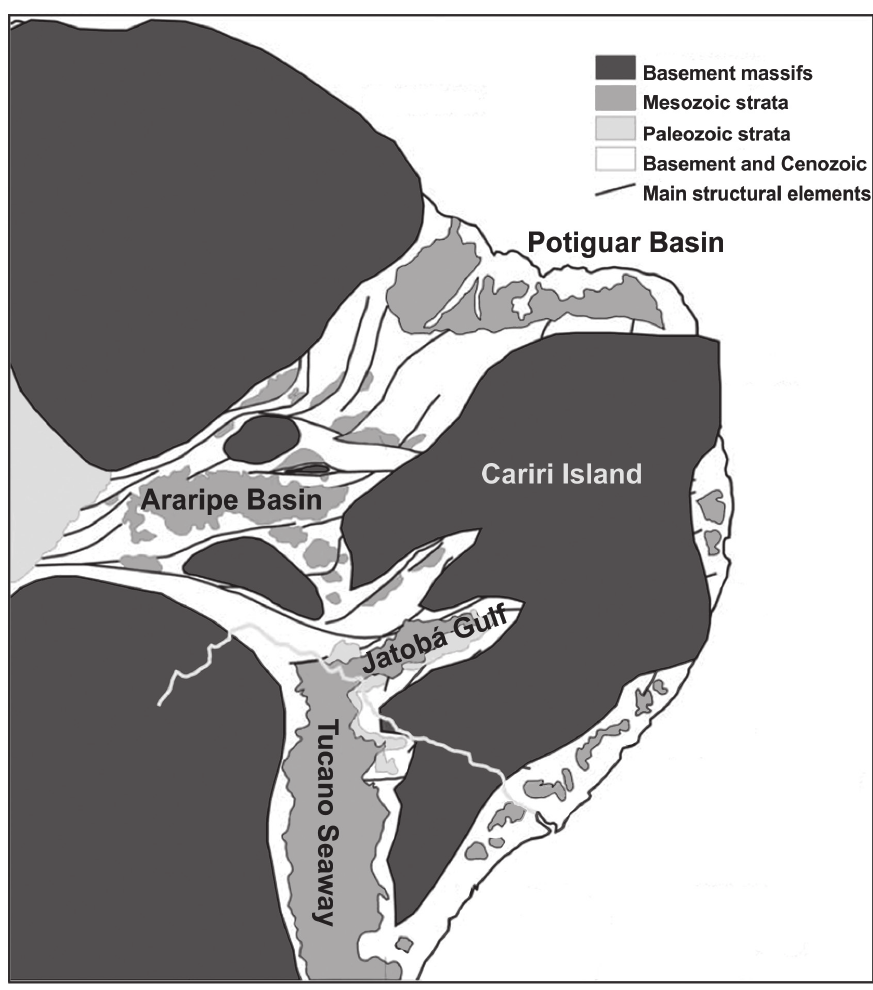
Figure 3 - Map showing possible intermittent marine connections between South and North Atlantic during Cretaceous (modified from Martill et al.